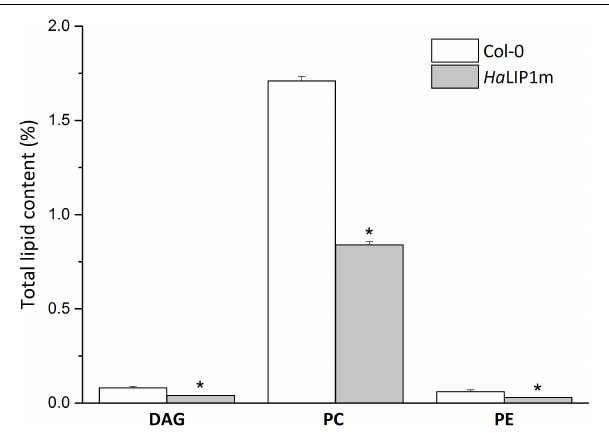
FIGURE 12 | Relative (in reference to the total lipids) diacylglycerols (DAG), phosphatidyl choline (PC) and phosphatidylethanolamine (PE) in control A. thaliana seeds (white bars) and seeds transformed with HaLIP1m (gray bars). The data represents the average of three biological replicates and (*) indicates a significant difference ( p <